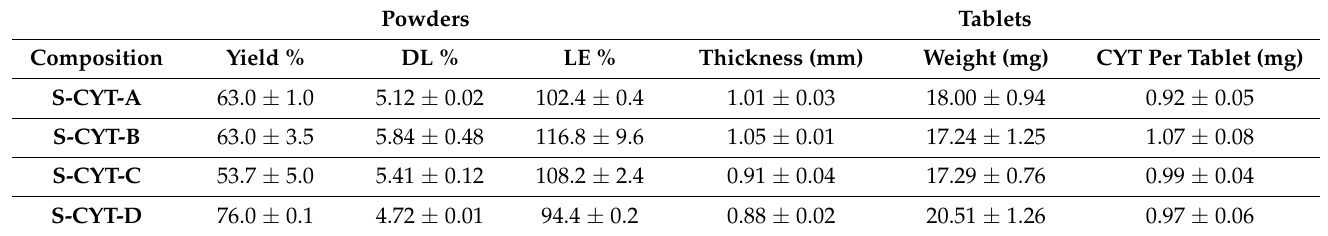
Table 3. Characterization of the CYT-loaded spray-dried powders (yield %, DL% and LE% ± SE; n = 3) and CYT-loaded buccal tablets (thickness, weight, and drug content ± SE; n = 9).